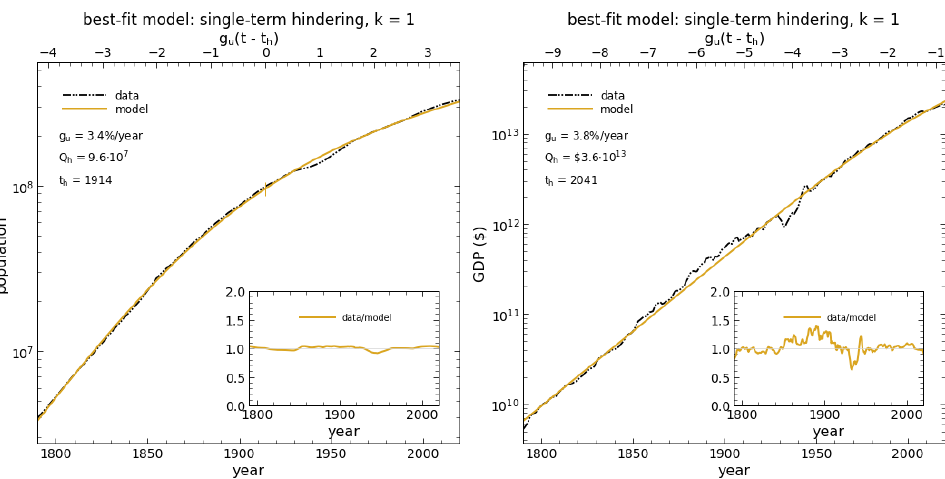
Figure 3. US Population ( left ) and GDP ( right ) from 1790 to 2020. The data are shown in dashed- dotted-dotted line; the GDP currency unit is $ = 2020 USD. In both cases, the best-fitting model, shown in solid line, is k = 1 sth with the listed parameters. The top axis shows x − x h (cf Equations (6) and (9)). The inset shows the ratio of data to